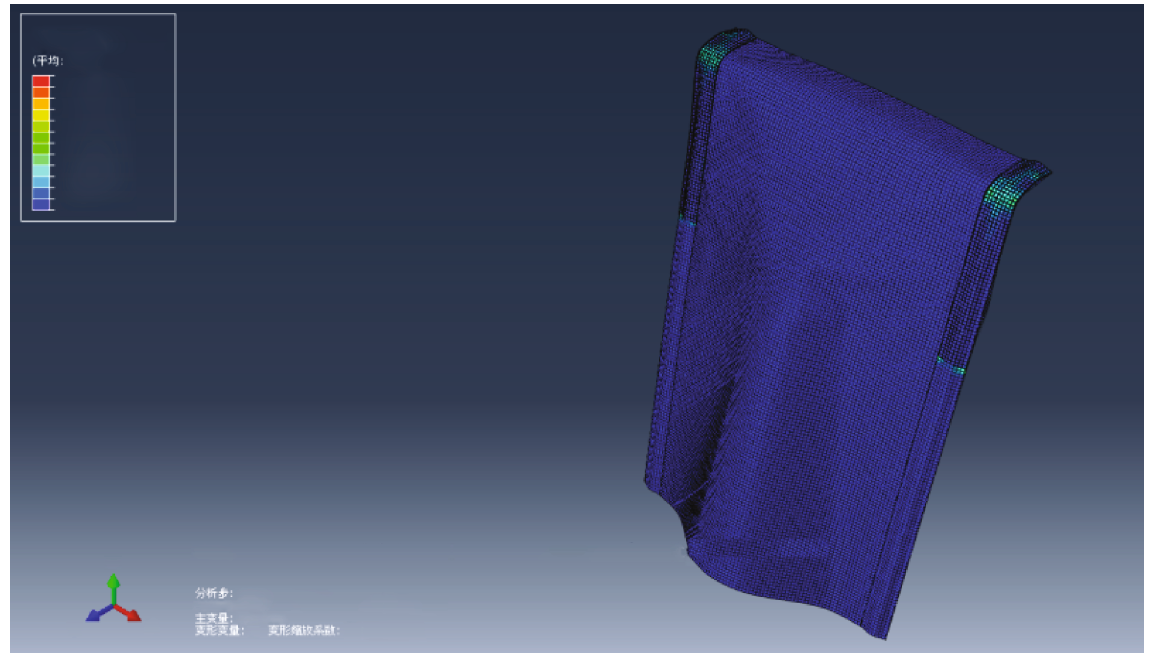
Figure 16: Con fi guration and stress distribution of the folded